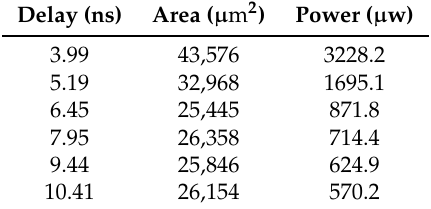
(b) Architecture in [22].